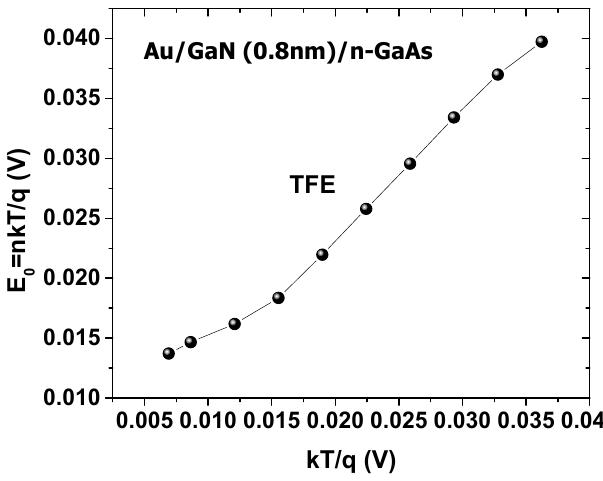
Figure 5. Variation of E 0 (nkT/q) versus kT/q.